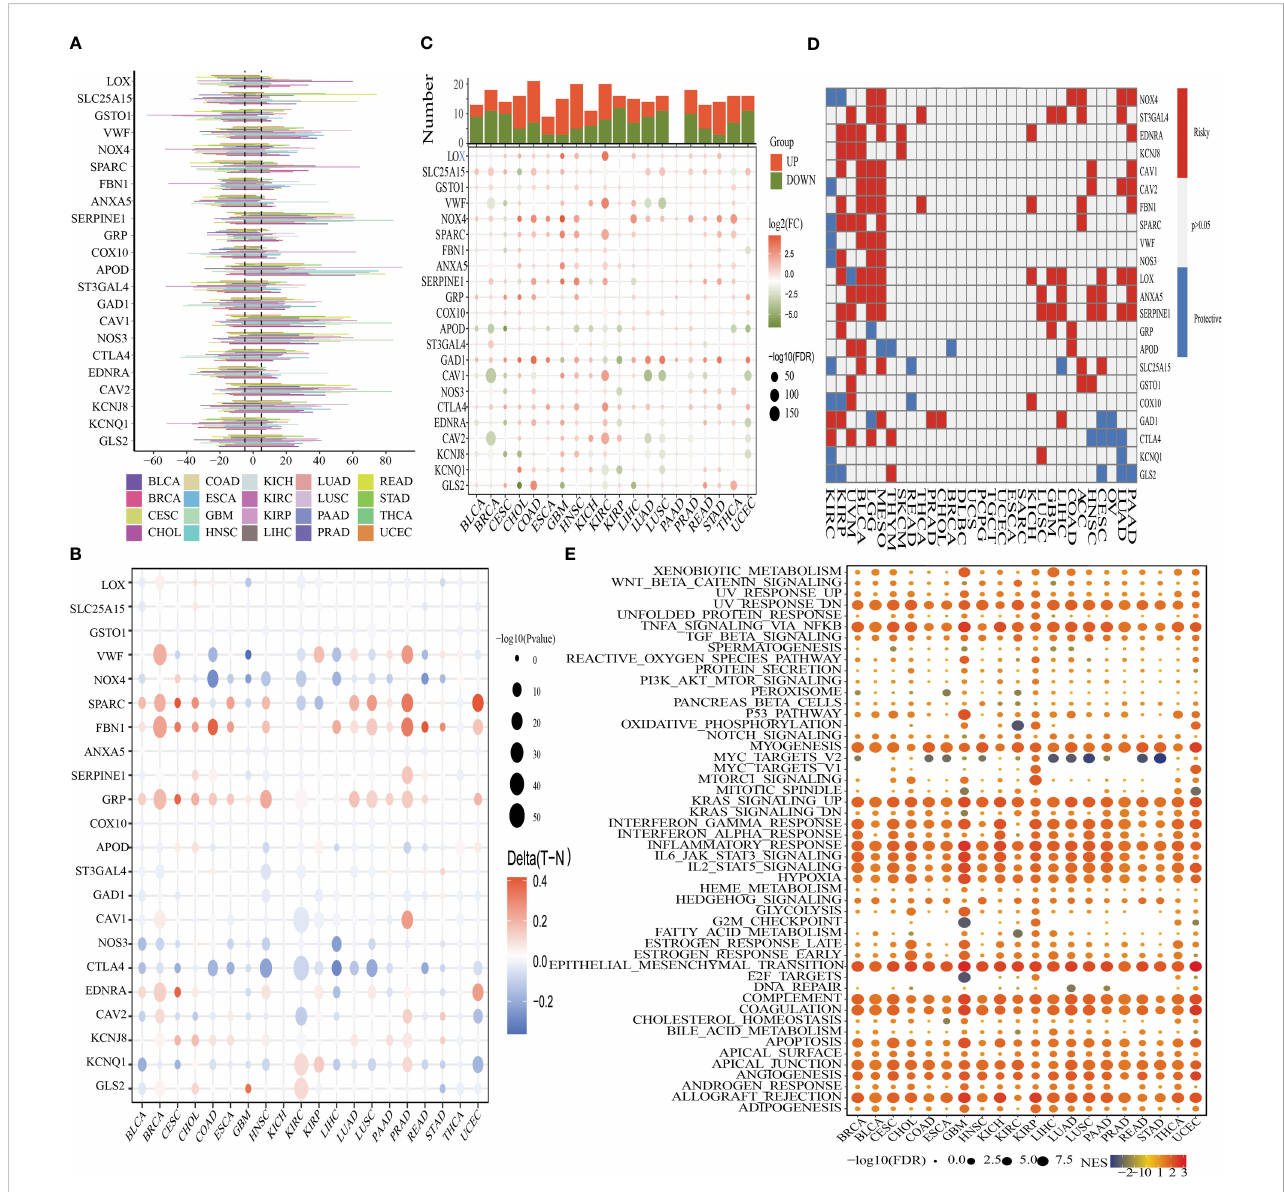
FIGURE 3 Panoramic depiction of OMRGs in pan-cancer. (A) The frequency of copy number variation (CNV) for each OMRG in each type of cancer is displayed in a histogram. (B) Genes that are hypermethylated and hypomethylated are indicated in red and blue, respectively, on a heatmap that displays the differential methylation of OMRGs in malignancies (Wilcoxon rank-sum test). (C) The histogram in the top panel shows the total number of substantially differentially expressed genes, whereas the heatmap depicts the fold change and FDR of OMRGs in each tumor. (D) OMRGs ’ survival pro fi les across cancers. (E) Comparison of tumor samples with high and low OMRGs scores by performing enrichment analysis for cancer pathway